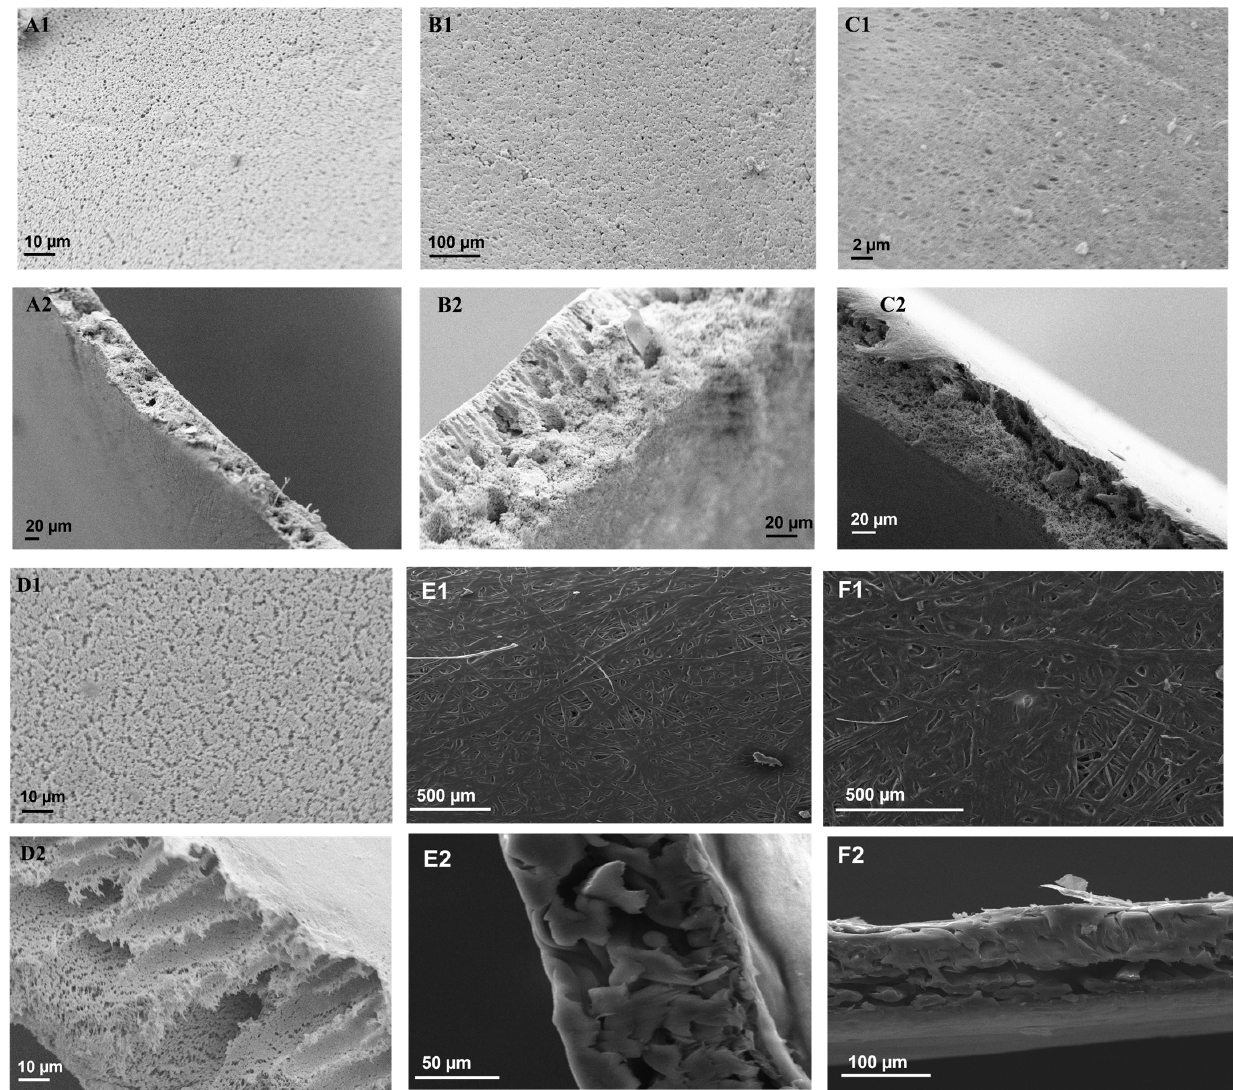
Figure 2. Surface and cross-sectional SEM micrographs of ( A1 , A2 ) M1, ( B1 , B2 ) M2, ( C1 , C2 ) M3, and ( D1 , D2 ) M4, ( E1 , E2 ) PTFE-20, and ( F1 , F2 ) PTFE-45. ( D1 , D2 ) M4, ( E1 , E2 ) PTFE-20, and ( F1 , F2 )